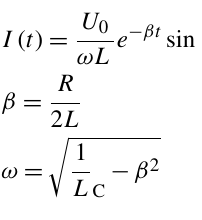
Figure 2. RLC equivalent circuit of the EMF process.